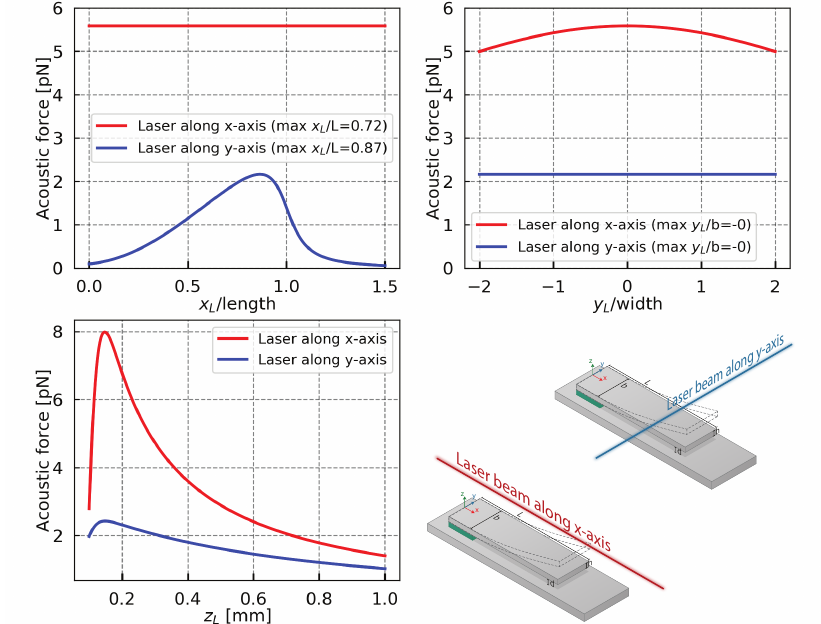
Figure A1. Amplitude of the photoacoustic force applied on a cantilever as a function of the laser beam position for two configurations: red—laser beam along the x-axis; blue—laser beam along the y-axis. Where f n = 11 kHz, b = 50 µ m, h = 100 µ m, and L = 3.5 mm, respectively are the resonance frequency, the width, the thickness, and the length of the cantilever.